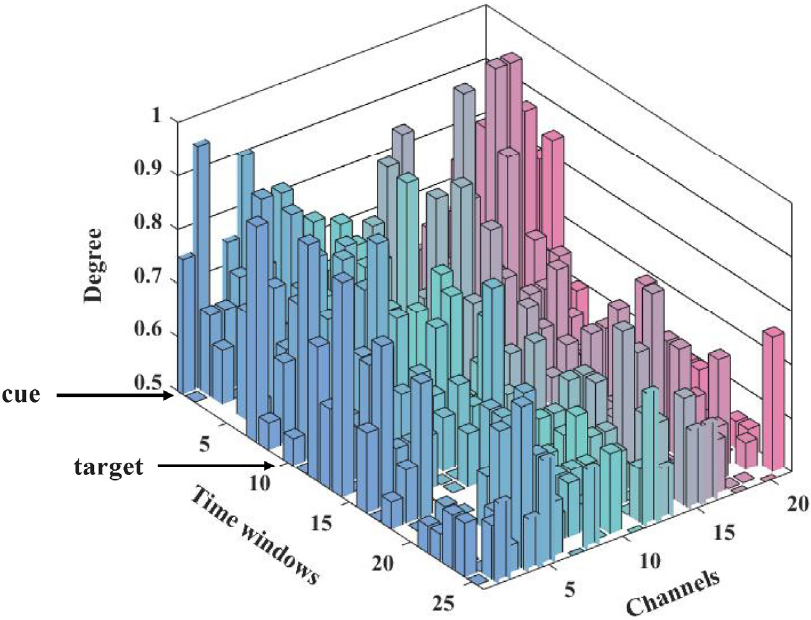
Figure 9. The degree of each channel during the whole-time courses of orienting. X axis: these channels numbers indicated the 21 canonical electrodes used in network construction, as shown in Figure 8. Y axis: the time windows with 50-ms length during 0–1300 ms to the cue onset. Z axis: the degree of orienting, each colored bar demonstrates the degree of specific network node (channel) in each time window, the values more than 0.5 were chose for comparing thoroughly.